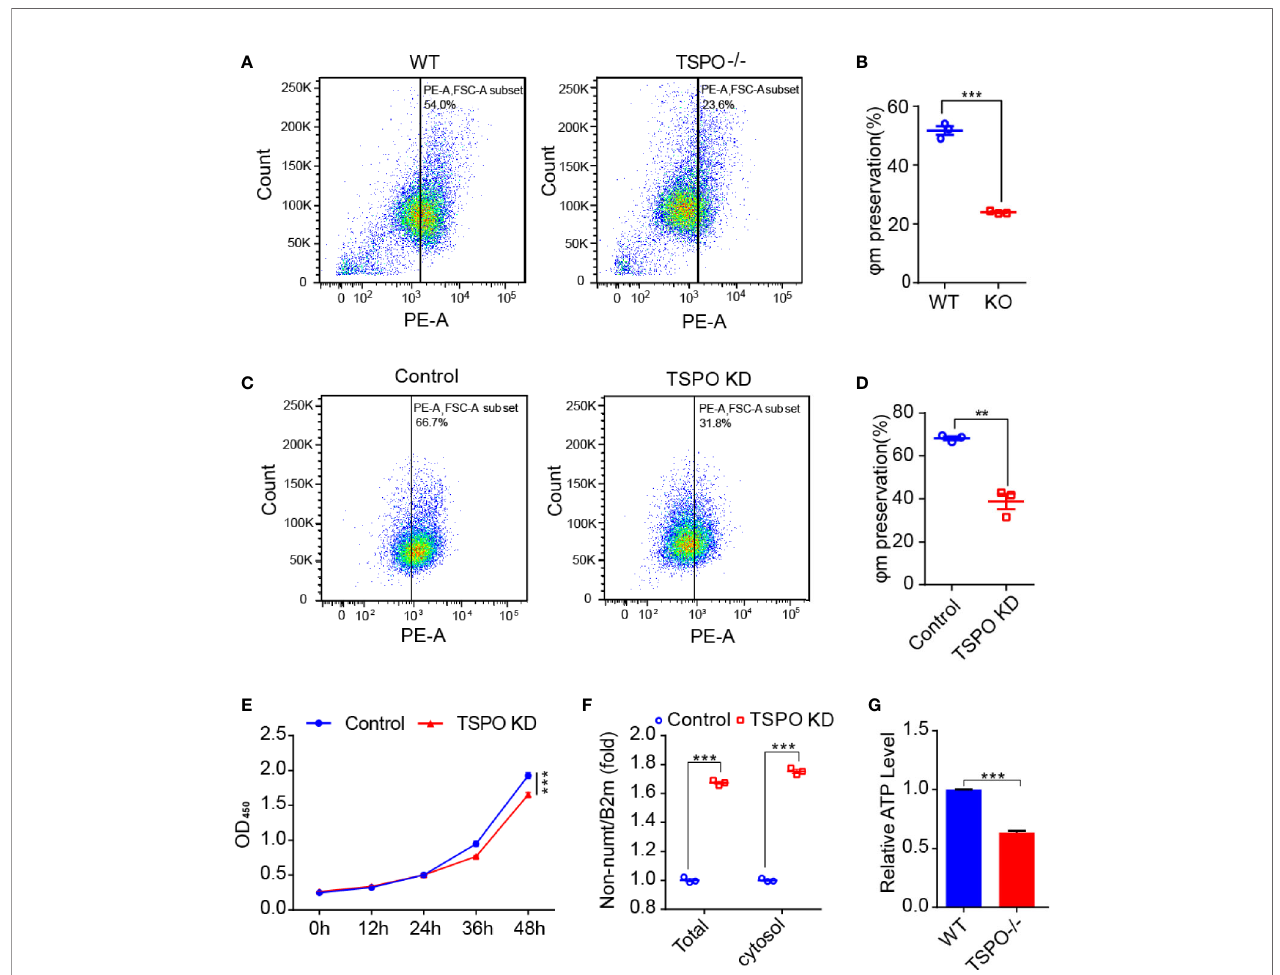
FIGURE 4 | TSPO knockout dampens microglial mitochondrial function. (A, B) The mitochondrial membrane potential ( Y m) of WT and TSPO − / − microglial cells was measured by TMRM fl uorescence (n=3 biological replicates). (C, D) The mitochondrial membrane potential ( Y m) of shvector and shTSPO cells was measured by TMRM fl uorescence. (E) shvector and shTSPO knockdown cell lines were placed in 96-well plates at the same density, and OD450 values were detected by adding CCK at speci fi c times. (F) The relative total mtDNA production and the amount of mtDNA released in the cytosol of WT and TSPO − / − microglia cells were quanti fi ed by RT-qPCR with primers speci fi c for a region of mtDNA that is not inserted into nuclear DNA (non-NUMT) and primers speci fi c for nDNA (B2m). (G) Total ATP production of WT and TSPO − / − microglial cells. Data were analyzed using one-way ANOVA. **p < 0.01, ***p <